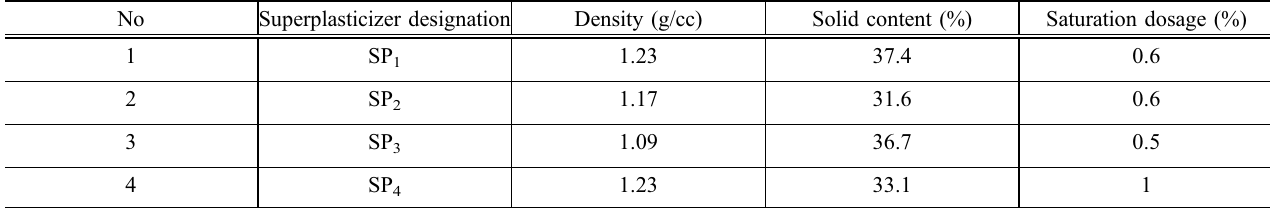
Table 2 Superplasticizer properties.